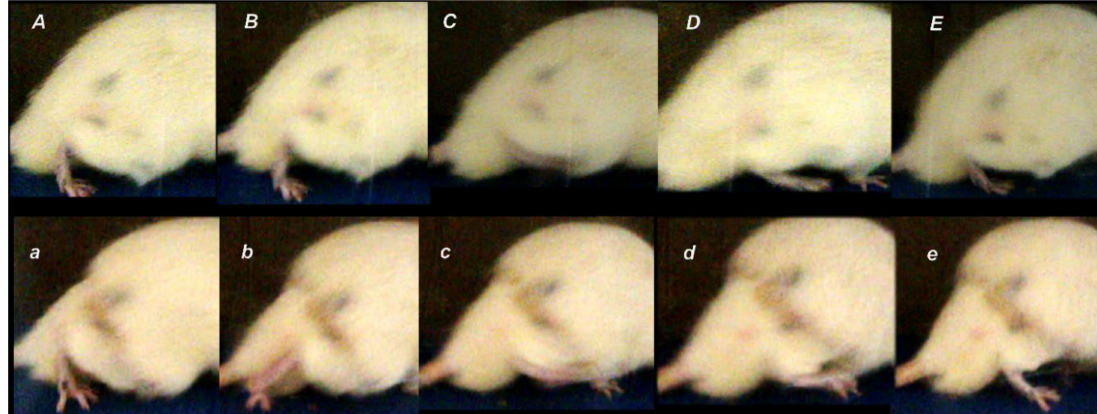
Figure 4. Illustrative presentation of the walking (cameras set sideways positioned) in the controls (low, a – e ) and BPC 157 treated rats (upper, A – E ). a , A . Stance phase. Control. Dorsiflexion foot, extended fingers, flexed knee, hip extension ( a ). BPC 157. Dorsiflexion foot, extended fingers, less flexed knee, hip less extension ( A ). b, B. Control initiates the swing phase, with prominent plantar flexion foot, flexed knee, and hip hyperextension ( b ). BPC 157 rat still in the stance phase, dorsiflexion foot, extended fingers, less flexed knee, hip extension ( B ). c , C. Controls. Swing phase. Dorsiflexion foot, flexed fingers, more flexed knee, hip flexed ( c ). BPC 157. Dorsiflexion foot, not flexed fingers, less flexed knee, hip flexed ( C ). d, D. Controls. Swing phase. Dorsiflexion foot, flexed fingers, more flexed knee, hip flexed ( d ). BPC 157. Dorsiflexion foot, not flexed fingers, less flexed knee, hip flexed ( D ). e , E. Stance phase. Control. Dorsiflexion foot, extended fingers, flexed knee, hip extension ( e ). BPC 157. Dorsiflexion foot, extended fingers, less flexed knee, hip less extension ( E ). Presentation of the foot sliding backward as a sudden jerk of the limb towards the back at the initiation of the swing phase ( b ) taken as an indicator of the failed walking, consistently present in control rats, but not in BPC 157 rats. Presentation at day 7 illustrative for all